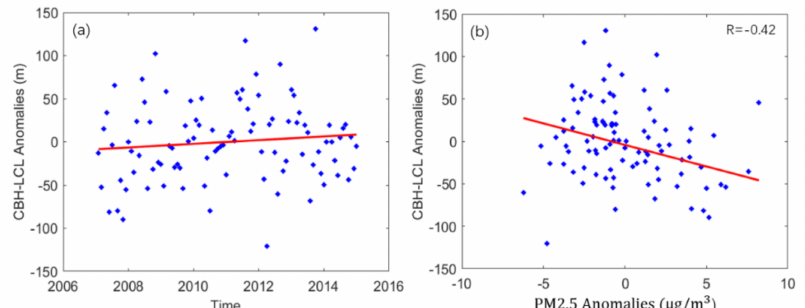
Figure 3. ( a ) Monthly CBH–LCL anomalies and ( b ) the relationship between CBH–LCL and PM 2.5 at BWI